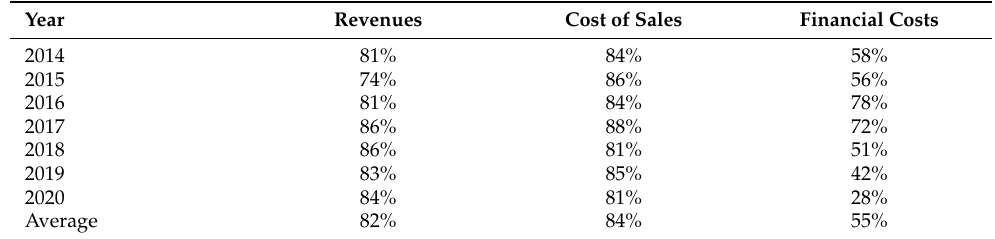
Table 15. Percentage share of the generation segment in the individual items of the consolidated financial statements of the ZE PAK Group from 2014 to 2020.